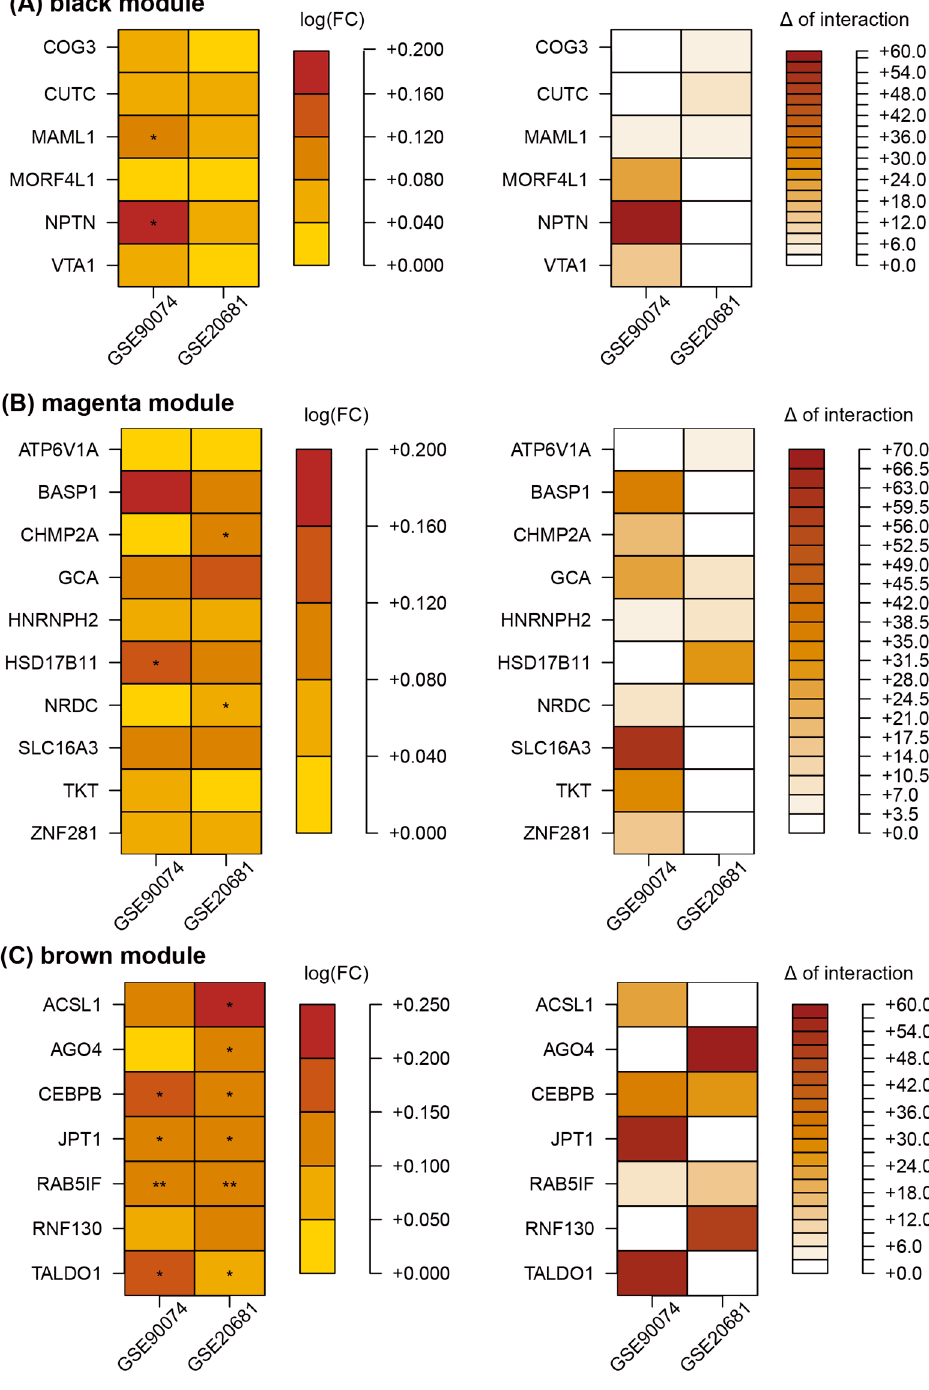
Figure 6. Representative obstructive CAD-related genes in the black ( A ), magenta ( B ), and brown ( C ) modules. FC values (logFC) between two conditions were calculated using the limma package. Delta ( Δ ) of interaction indicates the difference between the number of interactions in CVD and matched control groups. **, and * denote p < 0.01, and p < 0.05, respectively. Abbreviations: CAD, coronary artery disease; FC, fold change.